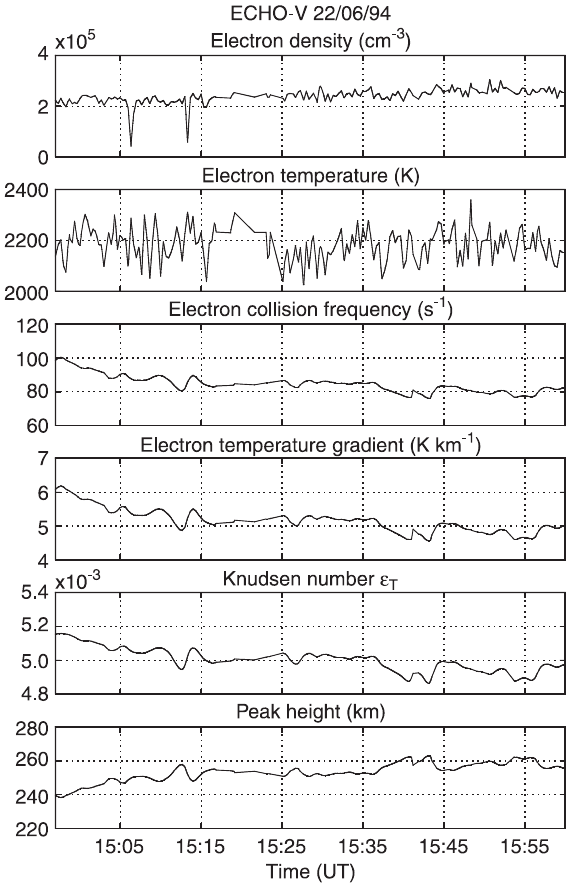
Fig. 6. The parameters for the ambient part of the electron distribution function interpolated at the altitude where the critical frequencies of the plasma lines are estimated ( bottom